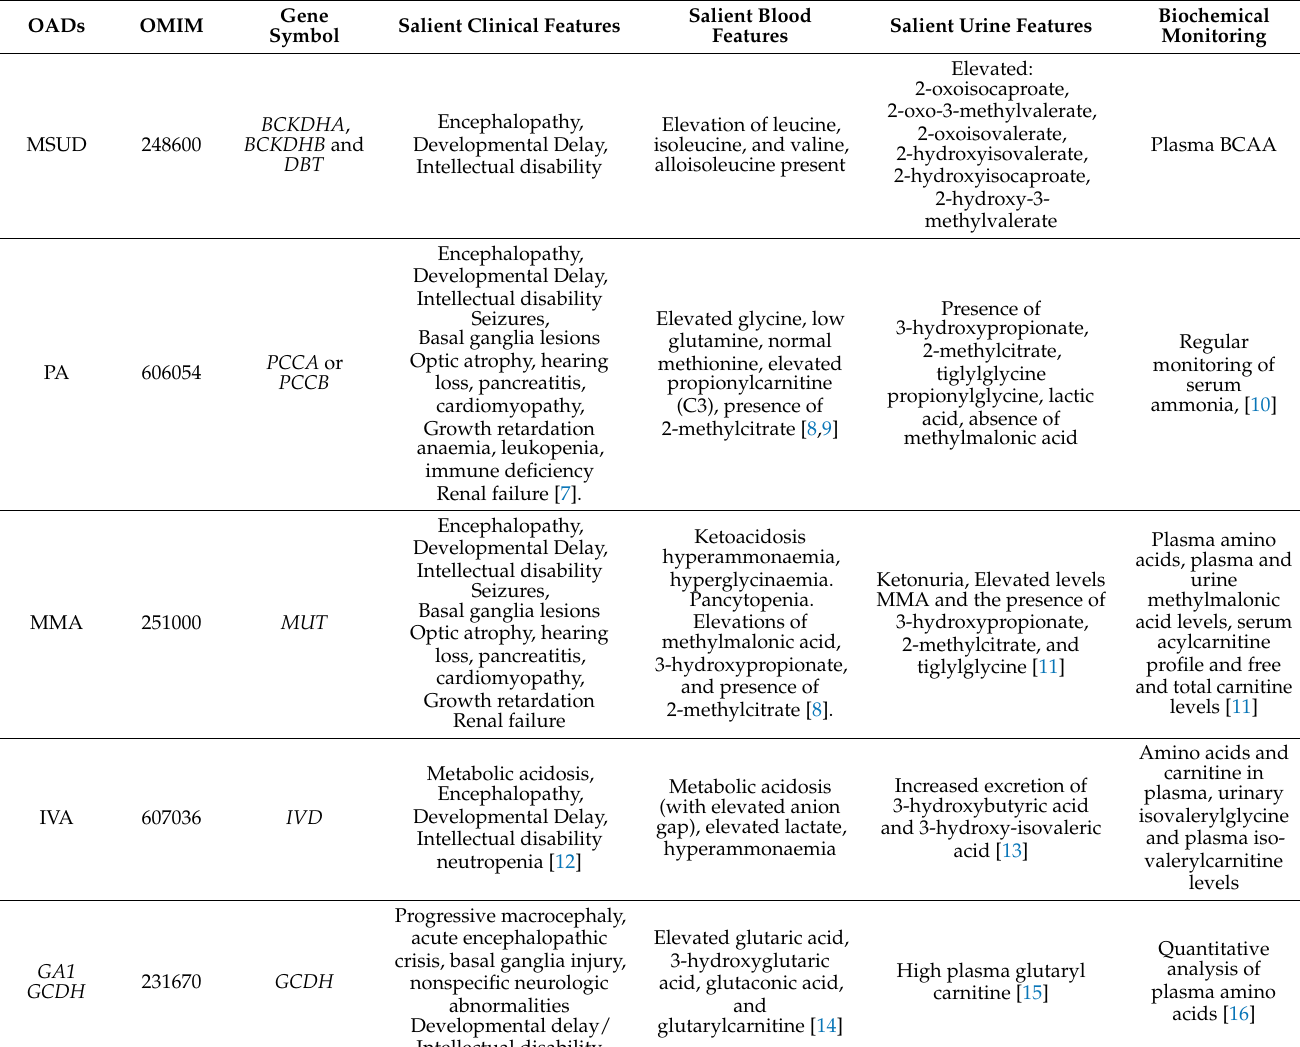
Table 1. Classical Organic Aciduria- Clinical and Biochemical